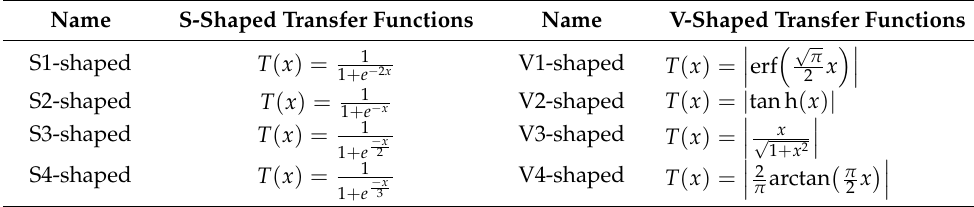
Table 1. The formulation of S-shaped and V-shaped transfer